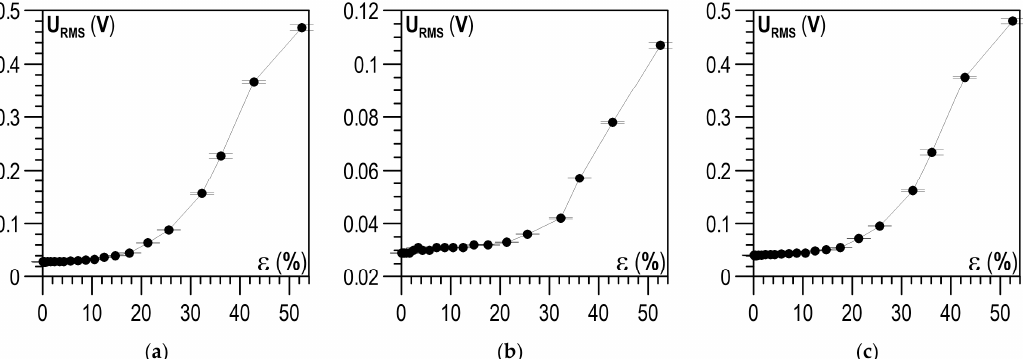
Figure 13. Relation between plastic deformation ε and U RMS : ( a ) parallel direction; ( b ) perpendicular direction; ( c ) module of directions.